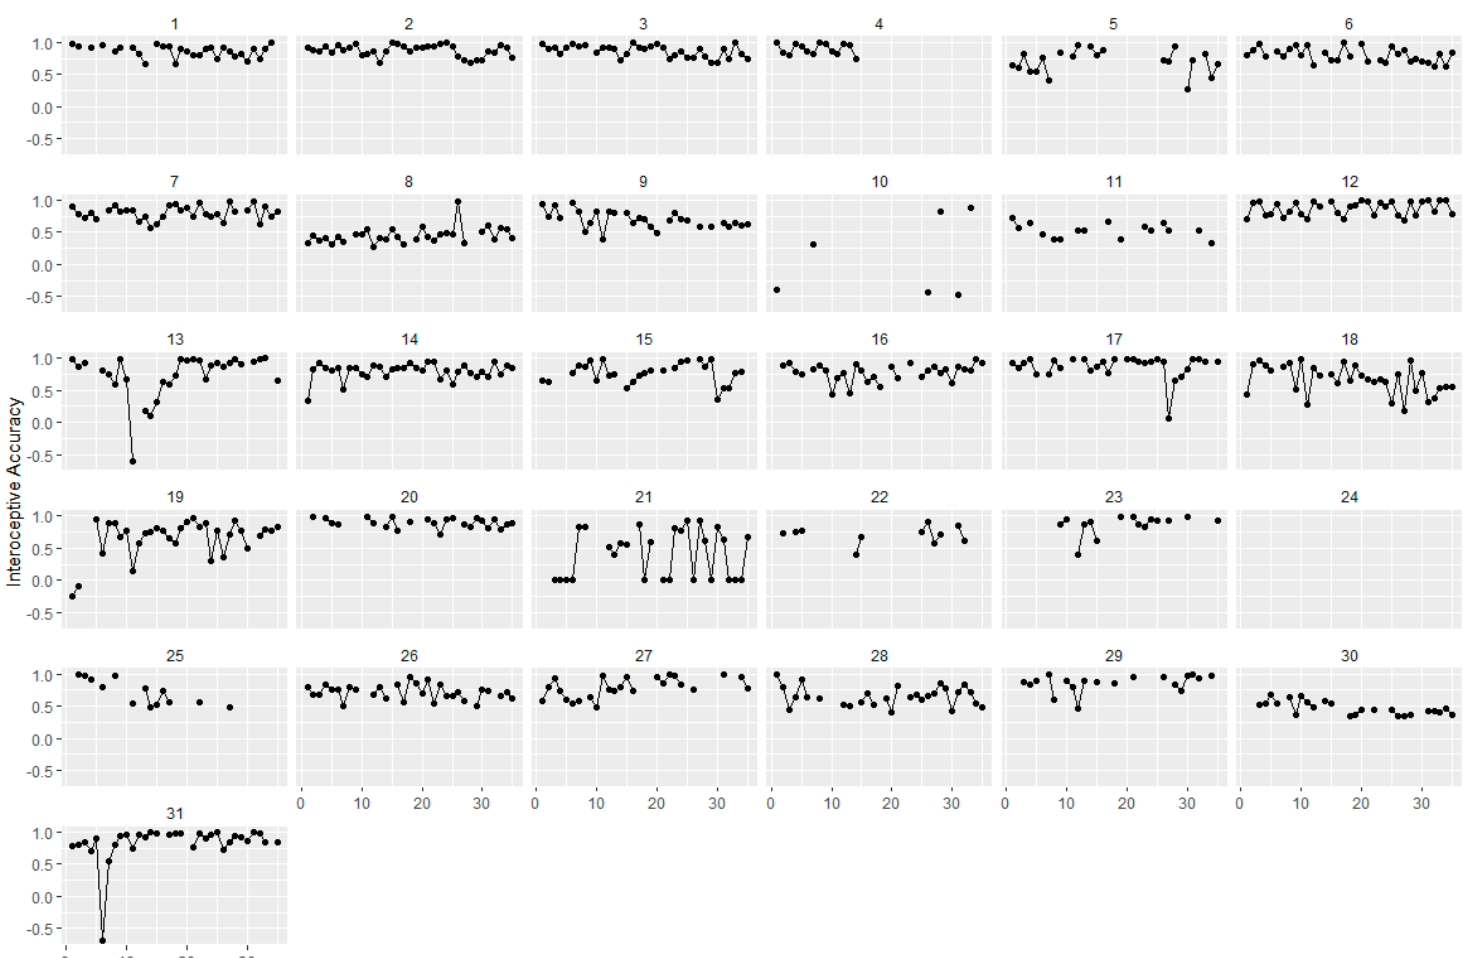
Figure 3. Interoceptive Awareness. Trajectories of interoceptive awareness for each of the 31 participants during EMA. Assessment points range from 1 to 35 over a time period of 7 days, interoceptive awareness ranges from − 100 to 100.